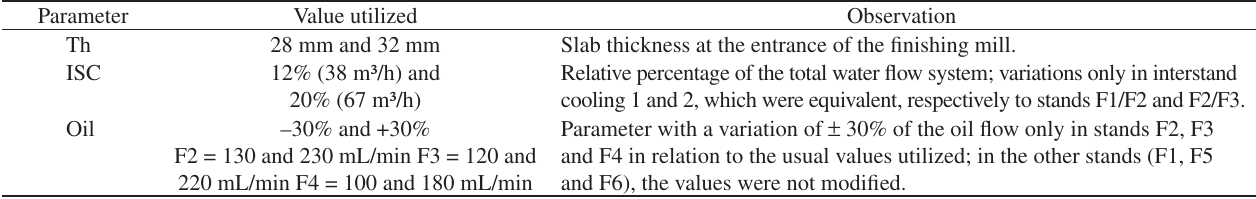
Table 2. Room temperature Mössbauer parameters obtained by the least-square fitting.